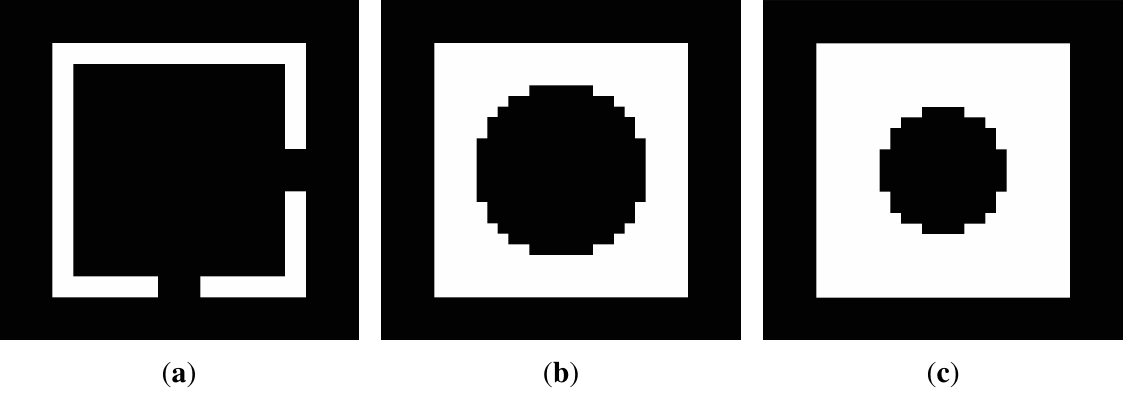
Figure 3. Two dimensional images obtained by slicing the structure illustrated in Figure 2: m , n and r represent three generic slices located at the z